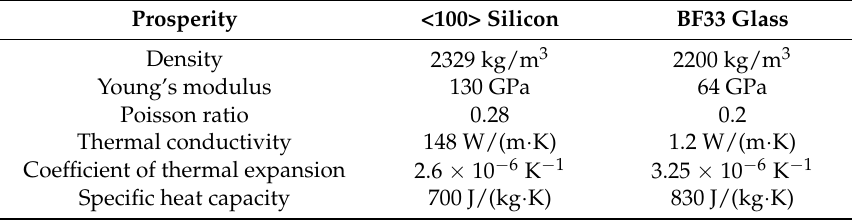
Table 2. The Material Prosperities of <100> Silicon and BF33 Glass.